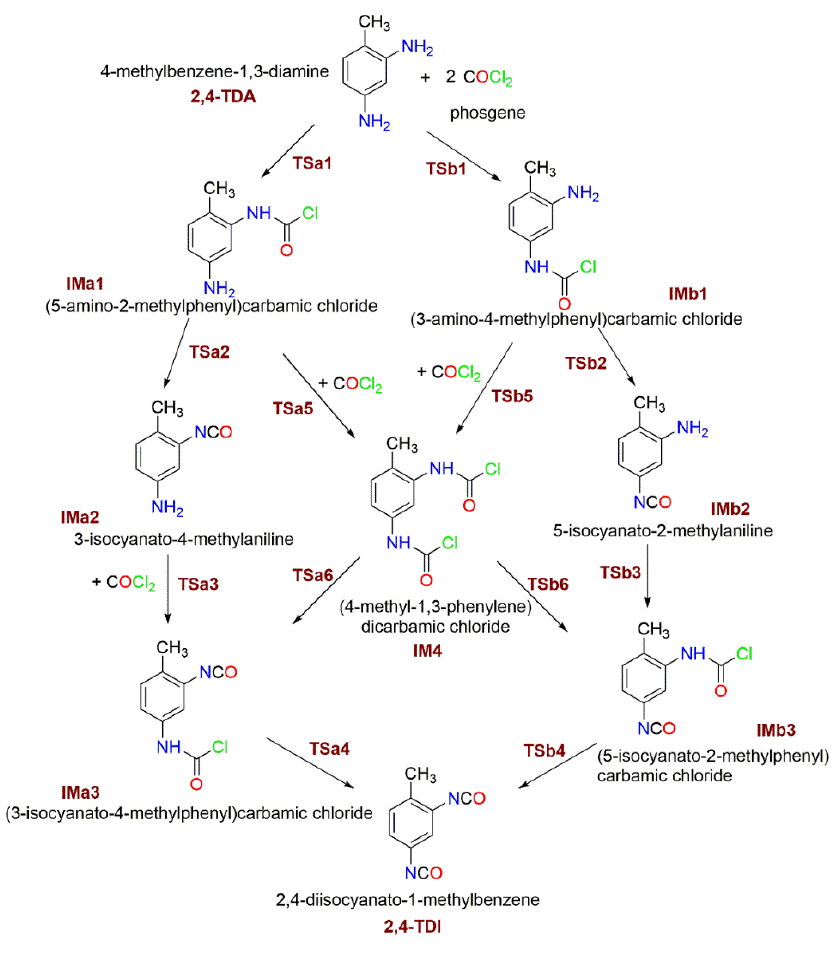
Figure 2. Studied reaction mechanism of the 2,4-TDA phosgenation.